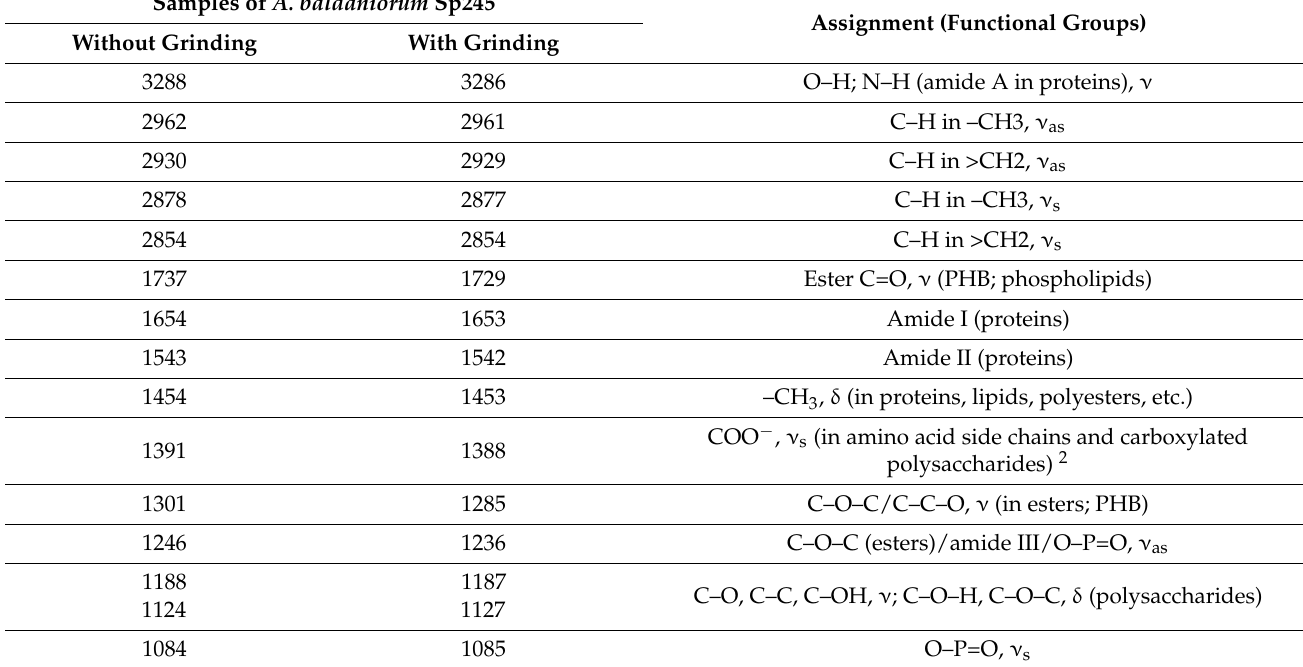
Table 1. Band maxima of typical vibration bands in FTIR spectra of dry biomass samples of A. baldaniorum Sp245 (see Figure 1a) and their assignments 1